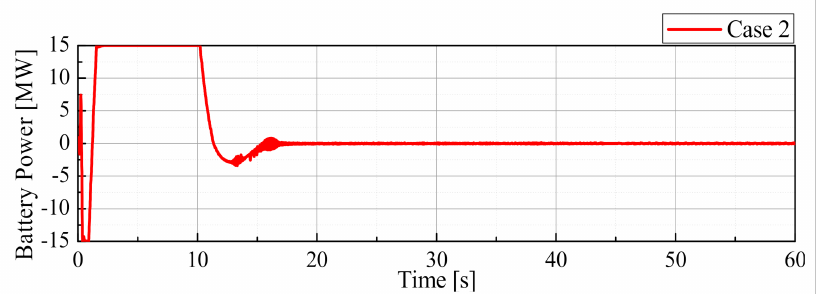
Figure 20. Generator rotor speed (Pumping Operation).